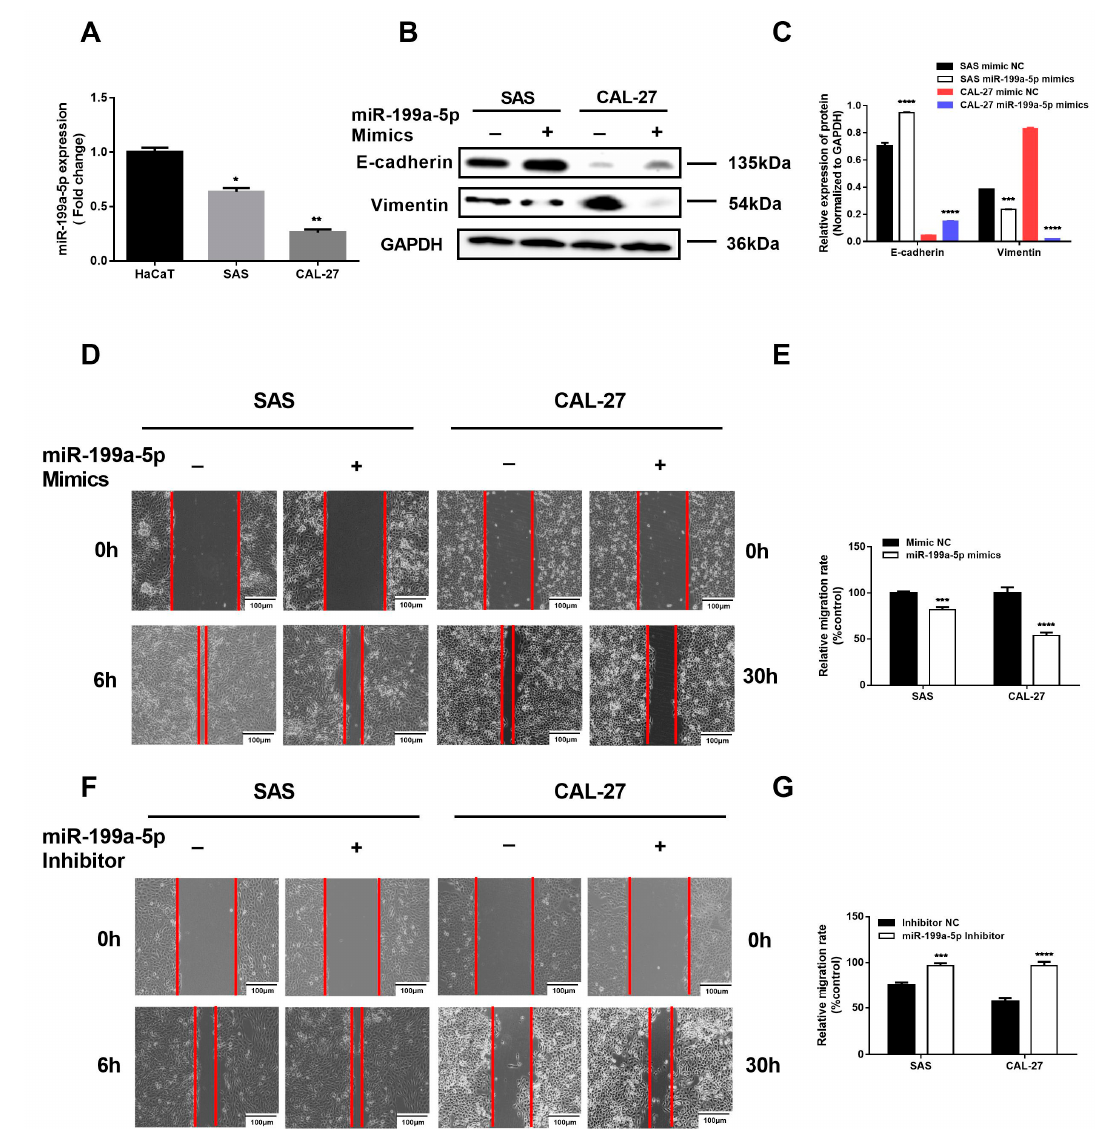
Figure 5. Effect of miR-199a-5p on OSCC cells EMT and migration. ( A ) Comparison of miR-199a-5p mRNA levels in SAS, CAL-27, and HaCaT. The miR-199a-5p mRNA level was detected by qRT-PCR. ( B ) The effect of miR-199a-5p mimics on OSCC cell E-cadherin and vimentin protein expression levels. SAS and CAL-27 cells were transfected with miR-199a-5p mimics 48h, and the E-cadherin or vimentin protein expression levels were measured by Western blot analysis. ( C ) The protein bands were analyzed by Image J. ( D – G ) The effect of miR-199a-5p mimics or miR-199a-5p inhibitor on OSCC cell migration. SAS cells or CAL-27 cells were transfected with miR-199a-5p mimics or miR-199a-5p inhibitor for the indicated times (6 h for SAS, 30 h for CAL-27), and cell migration was measured by the wound healing assay. Scale bar: 100 µ m ( D , F ). Quantitative analysis was performed using the Image J software ( E , G ). Data are expressed as the mean ± SEM from triplicate experiments. * p < 0.05, ** p < 0.01, *** p < 0.001, **** p <